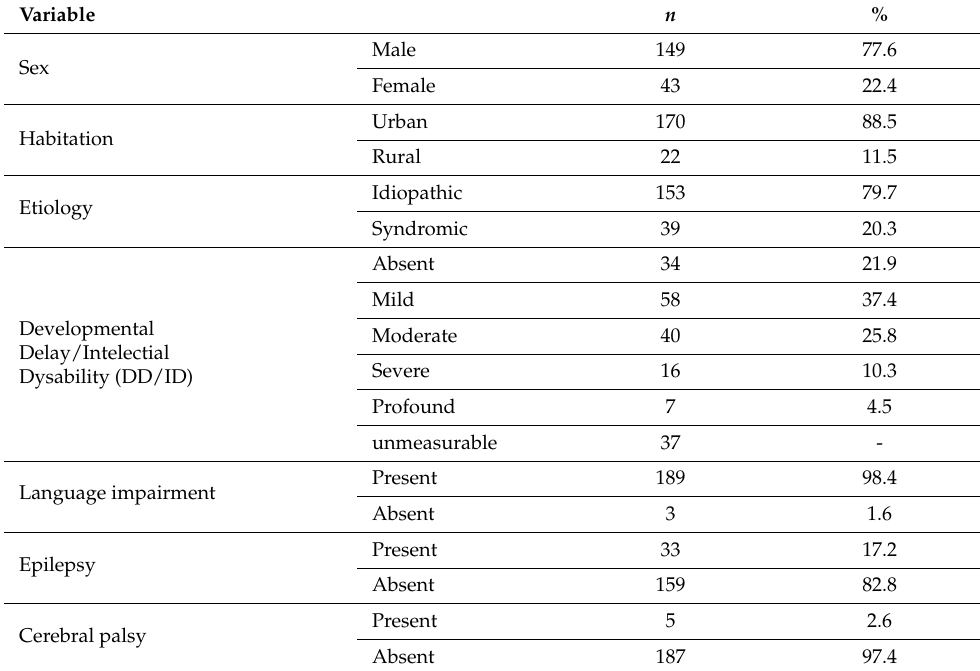
Table 1. Characteristics of the study